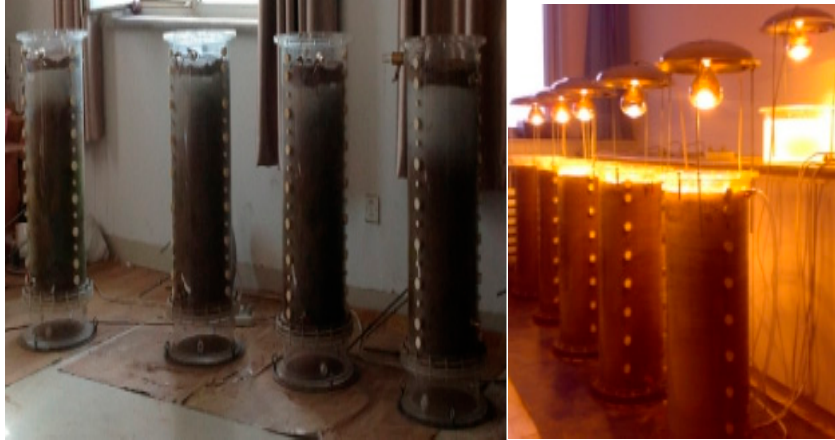
Figure 1. Lab soil column simulation experiment of infiltration and evaporation.